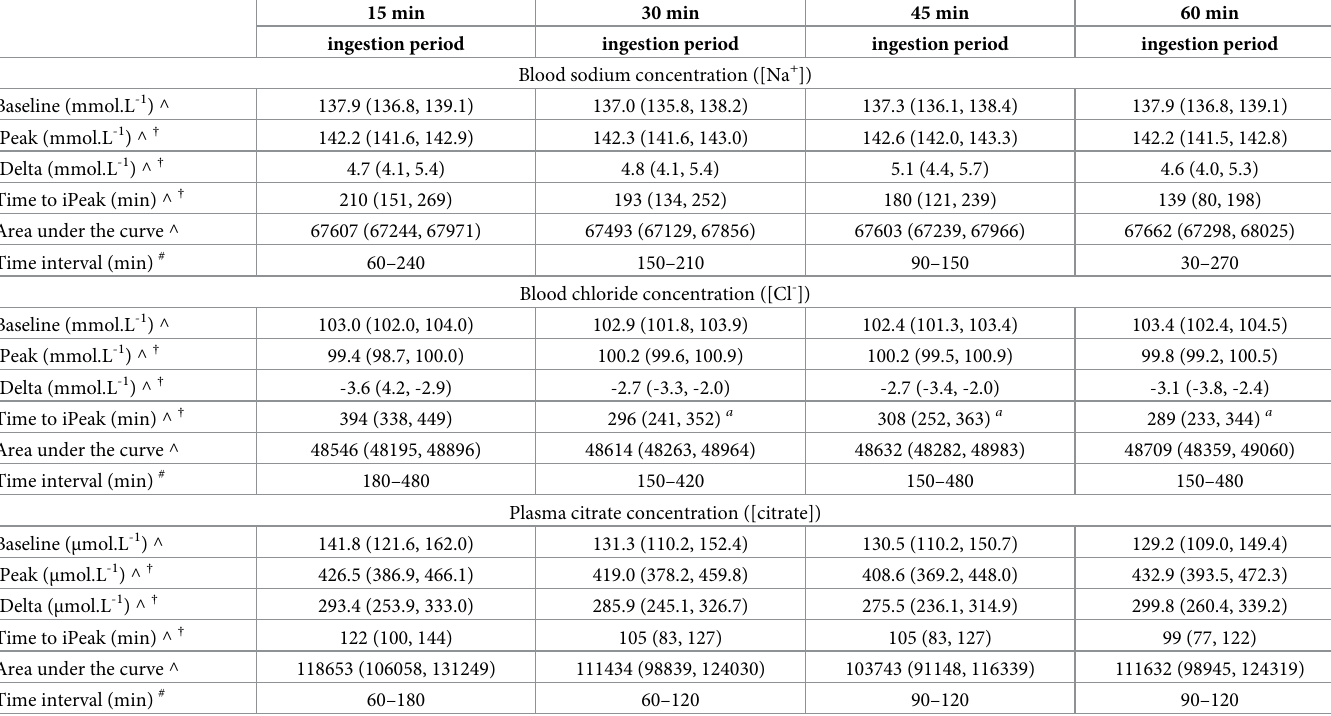
Table 3. Estimates of curve characteristics for blood sodium ([Na + ]), blood chloride ([Cl - ]) and plasma citrate ([citrate]) following ingestion of 500 mg.kg -1 BM sodium citrate over a 15, 30, 45 or 60 min period ( n = 16 participants per